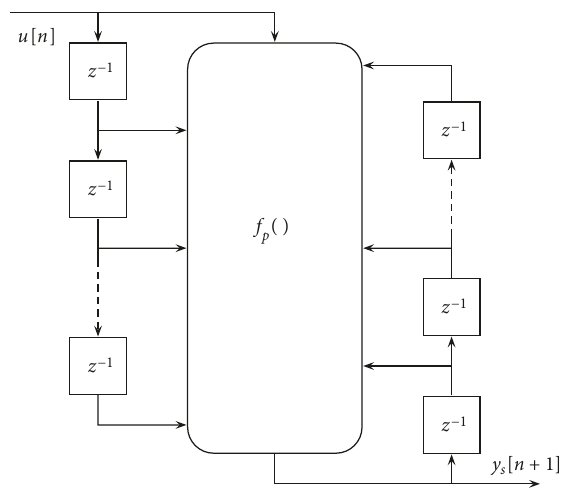
Figure 10: Scheme used for the plant identification.